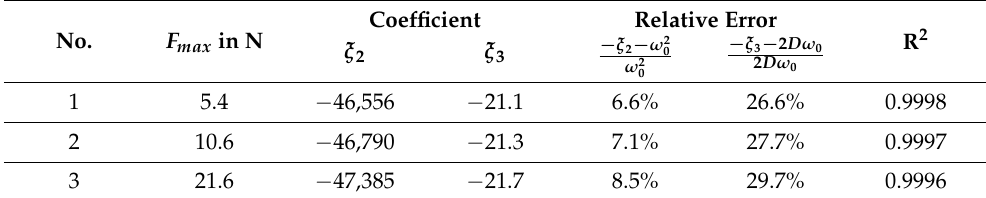
Table 6. Identified coefficients by using sweep signal excitation and their errors compared with theoretical